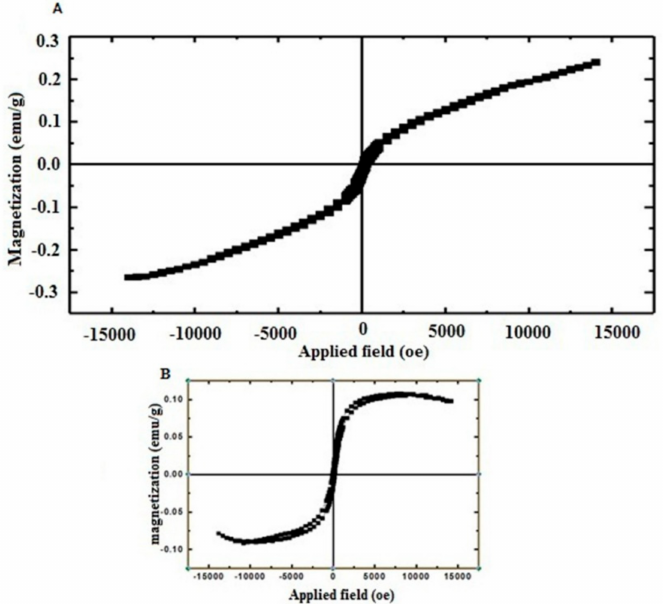
Figure 3. Vibrating sample magnetometer (VSM) results of ( A ) POM and ( B ) POM@CSIm.